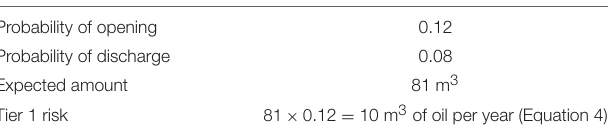
TABLE 4 | Results of a Tier 1 consequence assessment for wreck number